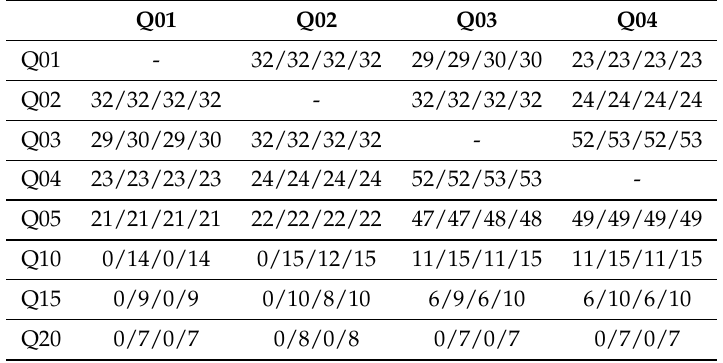
Table 11. Test results for similar Word documents with SiSe, part 1 (hash vs. hash/file vs. hash/hash vs. file/file vs. file).